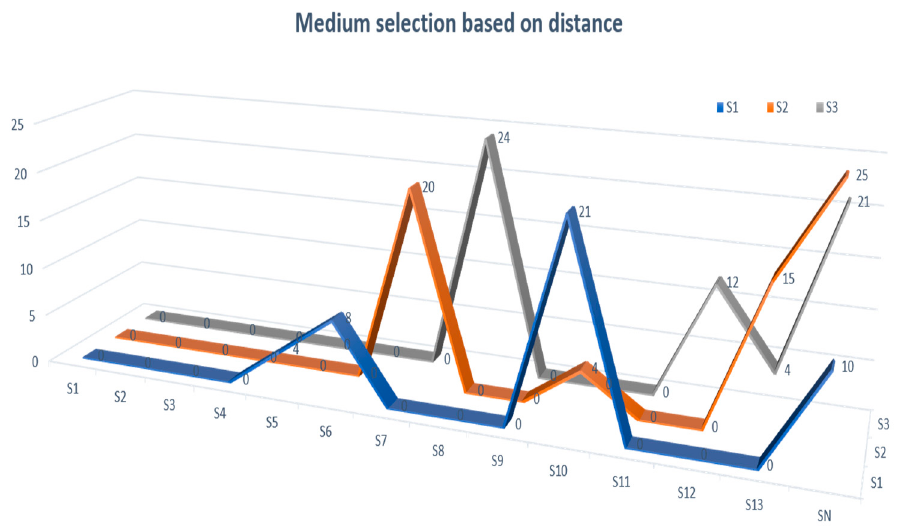
Figure 11 . Source to sink node routing using the medium selection mechanism. Figure 11. Source to sink node routing using the medium selection mechanism.